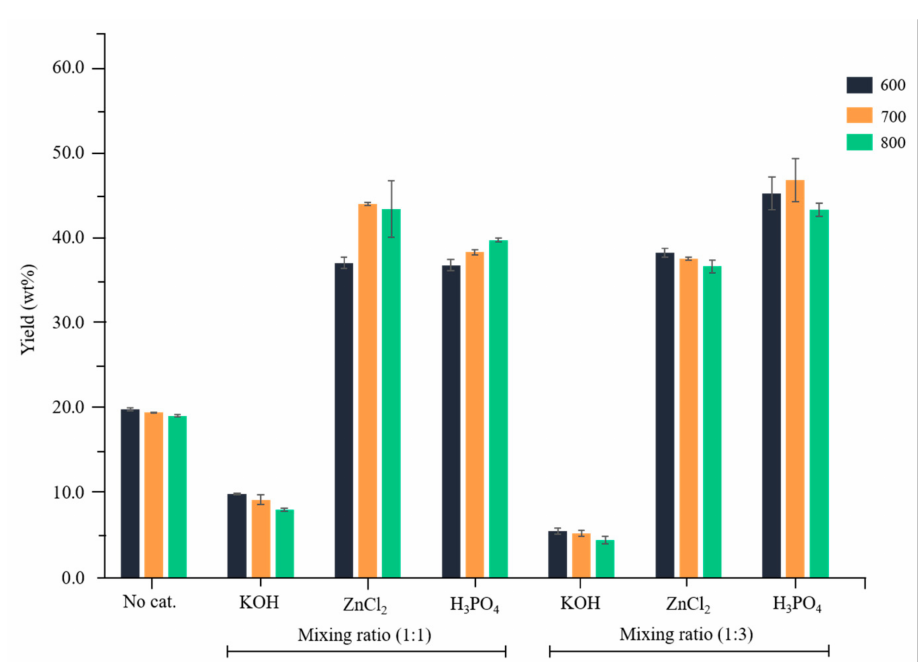
Figure 1. Comparison of yields of coffee waste activated carbon (CWAC) prepared by different temperatures, activating agents and mixing ratio of activating agent of 1:1 and 1:3, w / w .